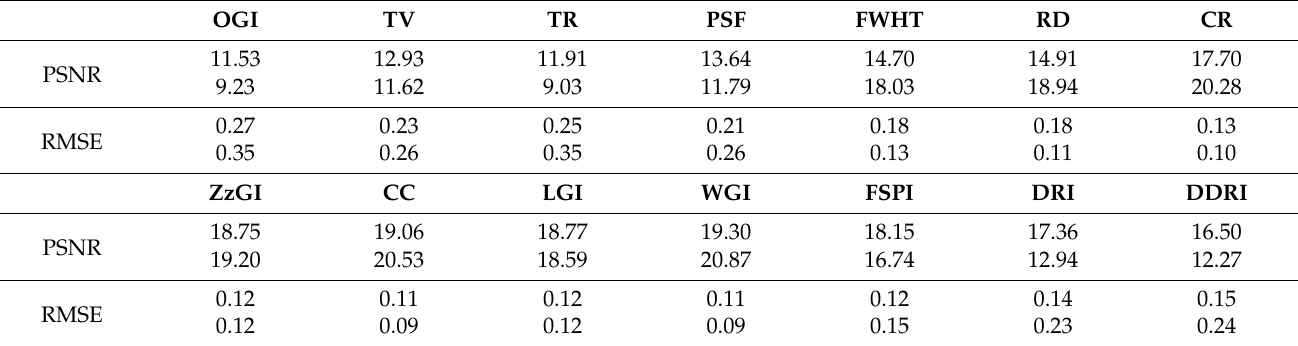
Table 4. PSNR and RMSE of images corresponding to Figure 4.